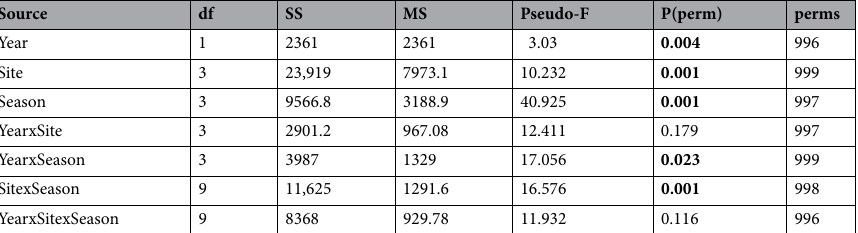
Table 3. Summary of results of permutational univariate analysis of variance (PERMANOVA) of the phytoplankton assemblages in the Sado Estuary for factors year, study site and season. “df”: degrees of freedom; “SS”: sum of squares; “MS”: mean squares; “Pseudo-F”: pseudo-F ratio; “P(perm)”: permutation P-value and “perms”: number of permutations. p -values smaller than 0.05 are presented in bold.